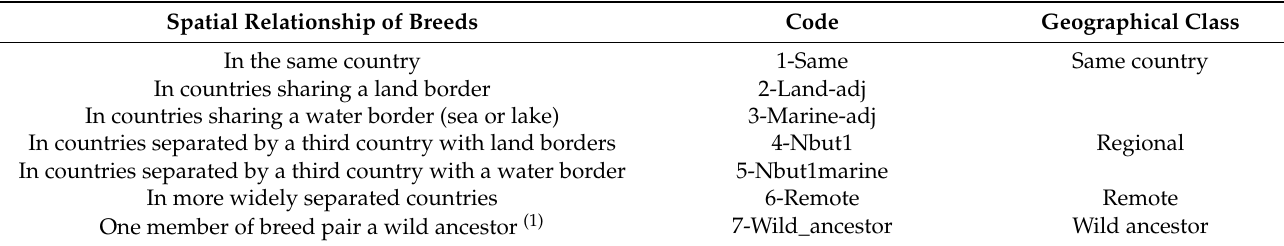
Table 2. Classification of geographical relationships of breed pairs.